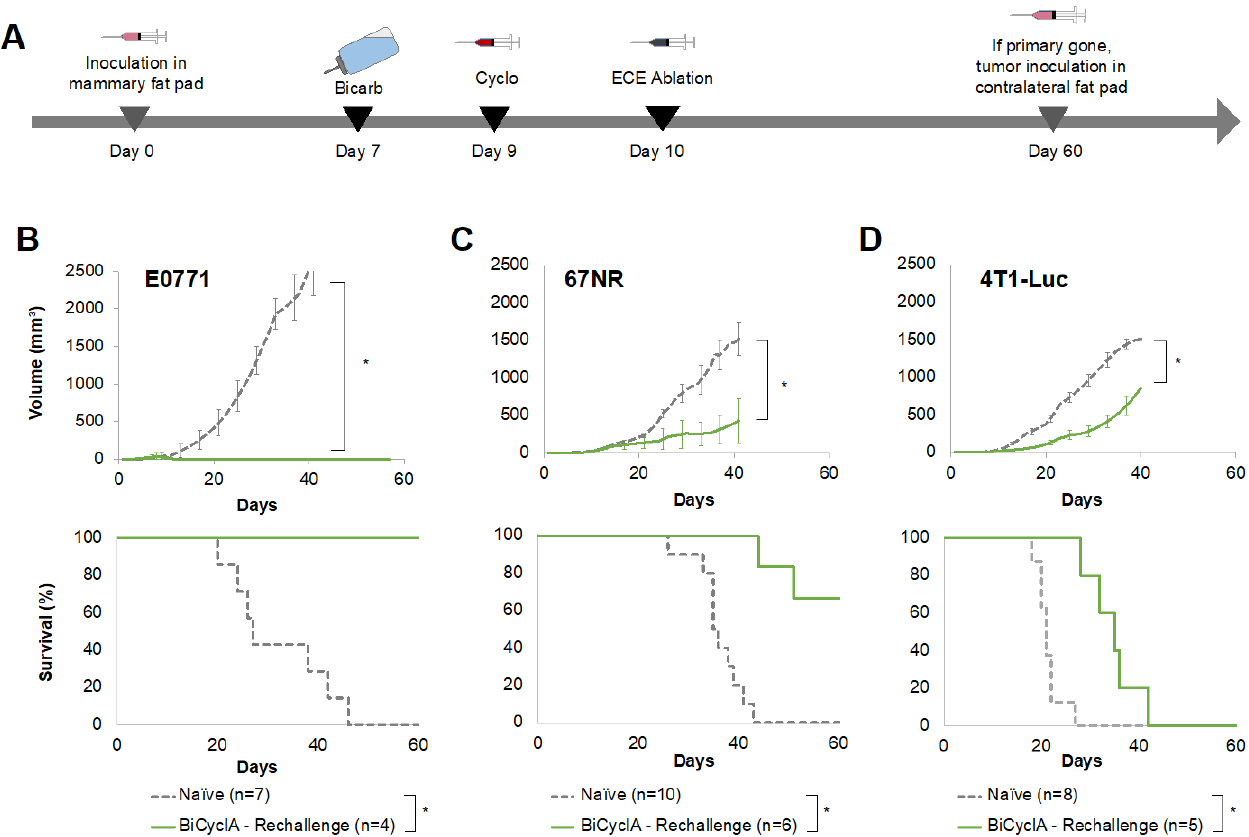
lines, suggesting a lasting anti-tumor response following BiCyclA therapy.